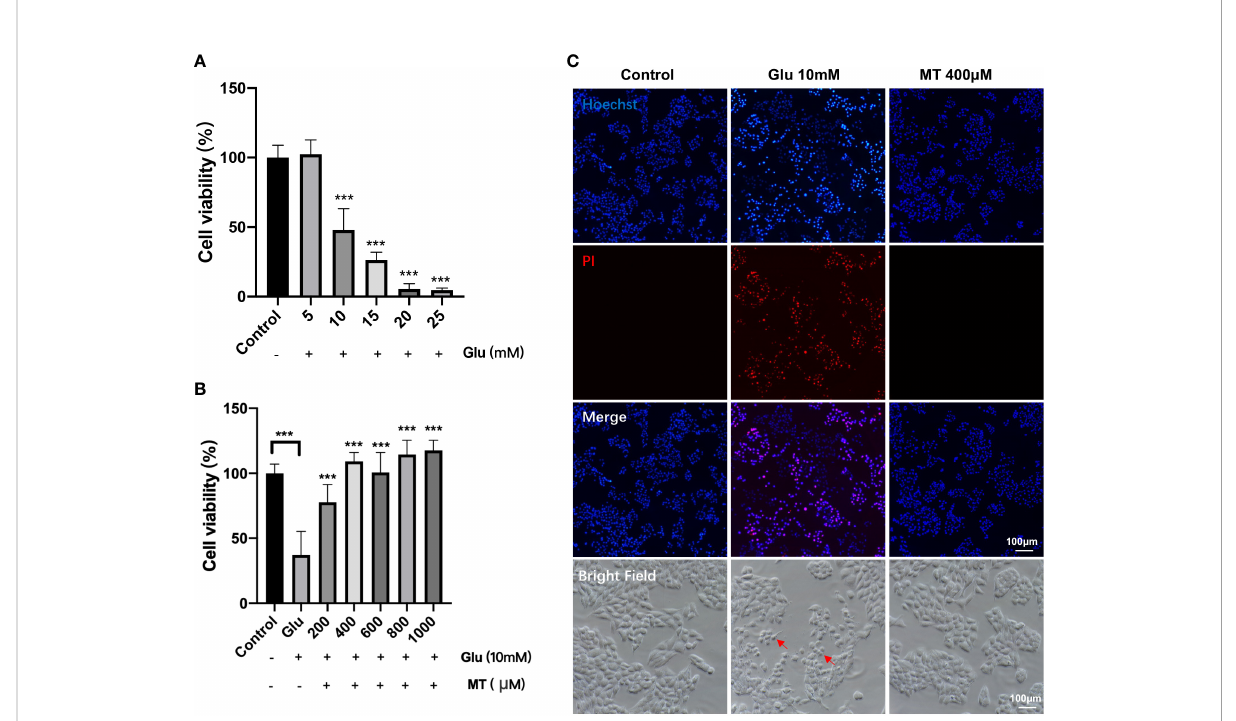
FIGURE 1 MT protects R28 cells from glutamate-induced excitotoxicity. (A) Effects of different concentrations of Glu on R28 cell viability after 24 h treatment. (n = 4) (B) Protective effect of different concentrations of MT on R28 cells treated with 10 mM glutamate for 24h. (n=6) (C) Pictures of R28 cells stained by PI and Hoechst. Red arrows: glutamate-induced excitotoxicity of R28 cells. Data are the mean ± SD; ***p < 0.001. Scale bar = 50